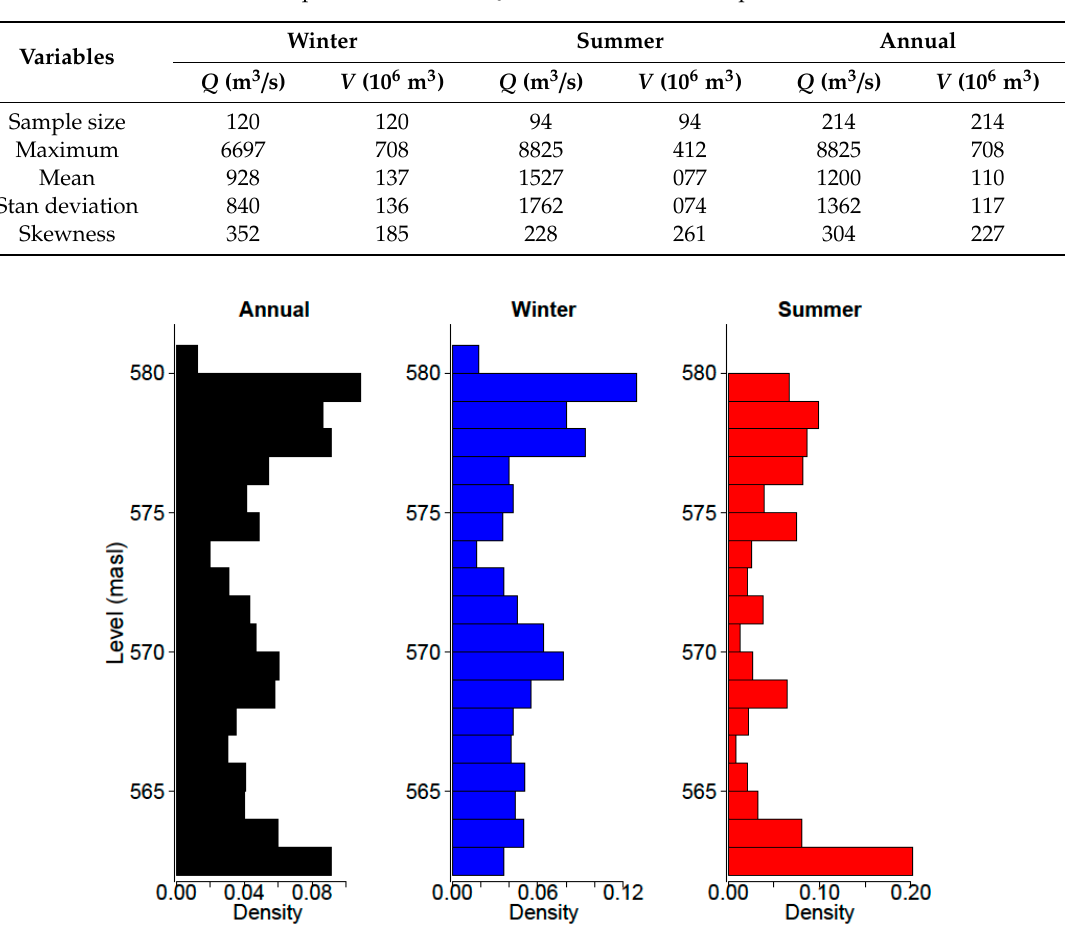
Figure 6. Empirical frequency distribution of the reservoir water level.